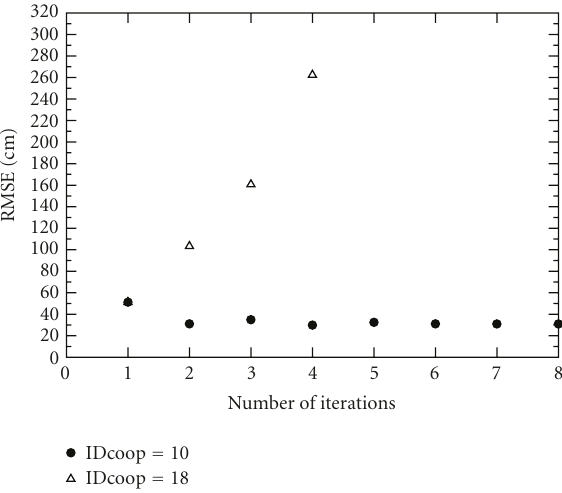
Figure 9: RMSE as a function of number of iterations when target 1, located in position 8, cooperates with target 2, in position 10 or 18. N = 3 (tx1,tx3,tx5) beacons are considered. The cooperative node is taken as reference for the LS algorithm.